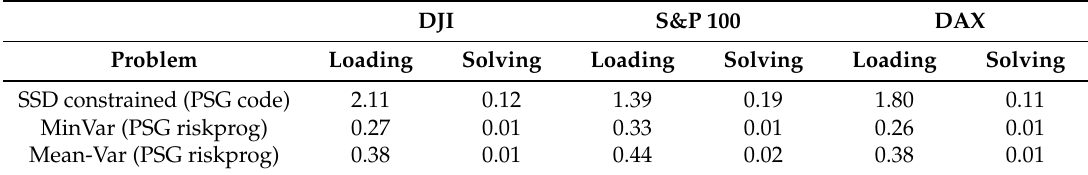
Table 2. Loading and solving times (in seconds) with PSG in the MATLAB